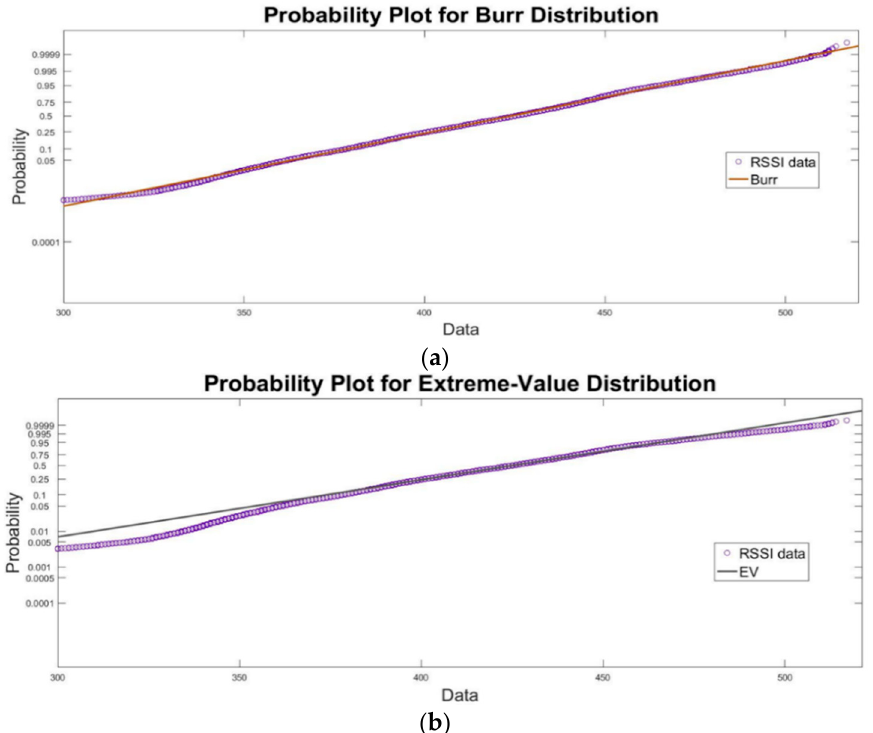
Figure 4. Probability plots for ( a ) Burr and ( b ) Extreme-Value distribution against RSSI data.